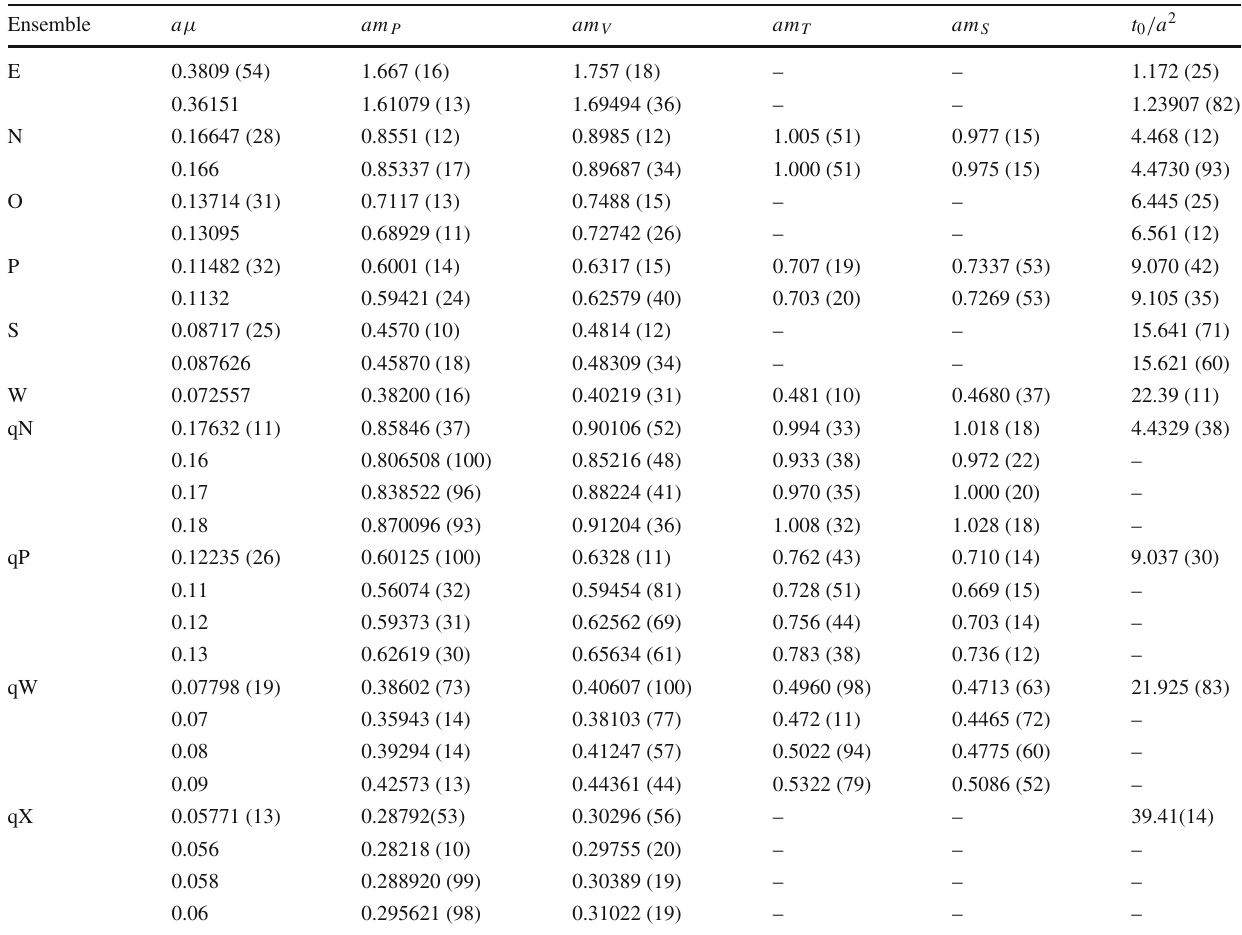
Table 6 Meson masses and t 0 in lattice units. For N f = 2 simulations the first line contains the values extrapolated to the tuning point μ (cid:15) and the second line the values at the simulated parameters. For N f = 0